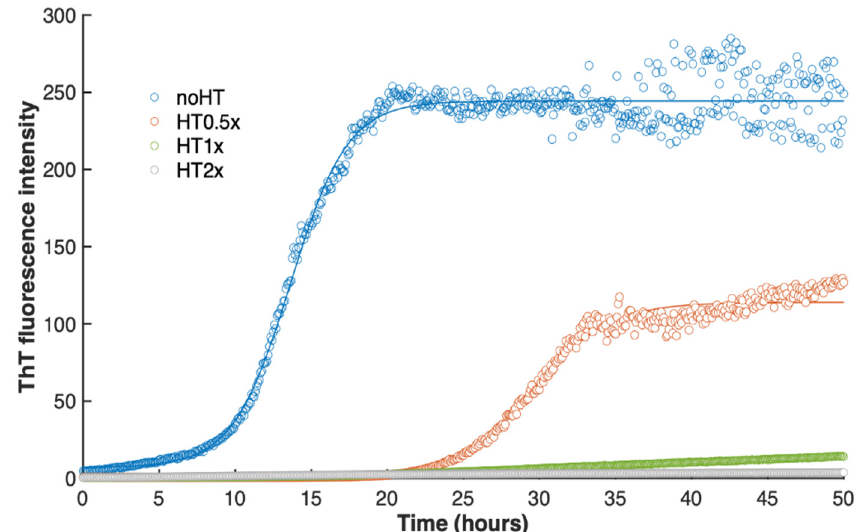
Figure 2. Effect of HT on insulin amyloid aggregation by Thioflavin T (ThT) assay. ThT fluorescence intensity recorded for insulin in aggregating conditions in the absence and in the presence of HT at 0.5, 1, and 2 x molar ratio. ThT emission was recorded at 482 nm upon excitation at 450 nm. The results are averages over triplicates for each sample condition. The solid line, reported as a guide for the eye, is the best fit to the data given by the sigmoidal equation f = y 0 + a / (1 + exp(x 0 − x)ˆc). Other experimental details are described in the Methods section.